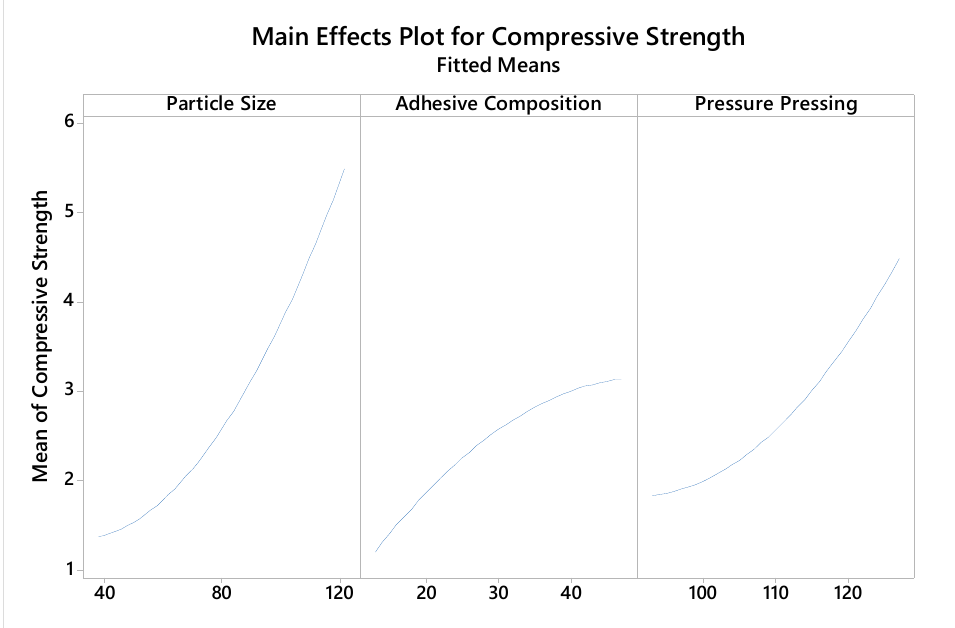
Figure 6. The main effect of process conditions on the compressive strength.